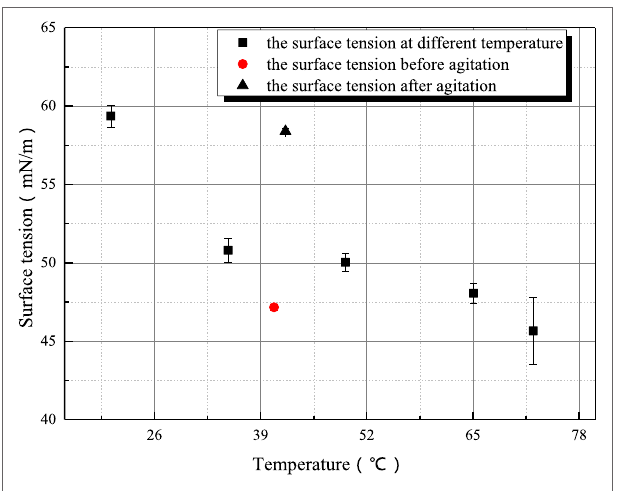
FigUre 7 | The influence of agitation on the surface tension of sodium hydroxide (sodium hydroxide concentration is 1 mol/L).